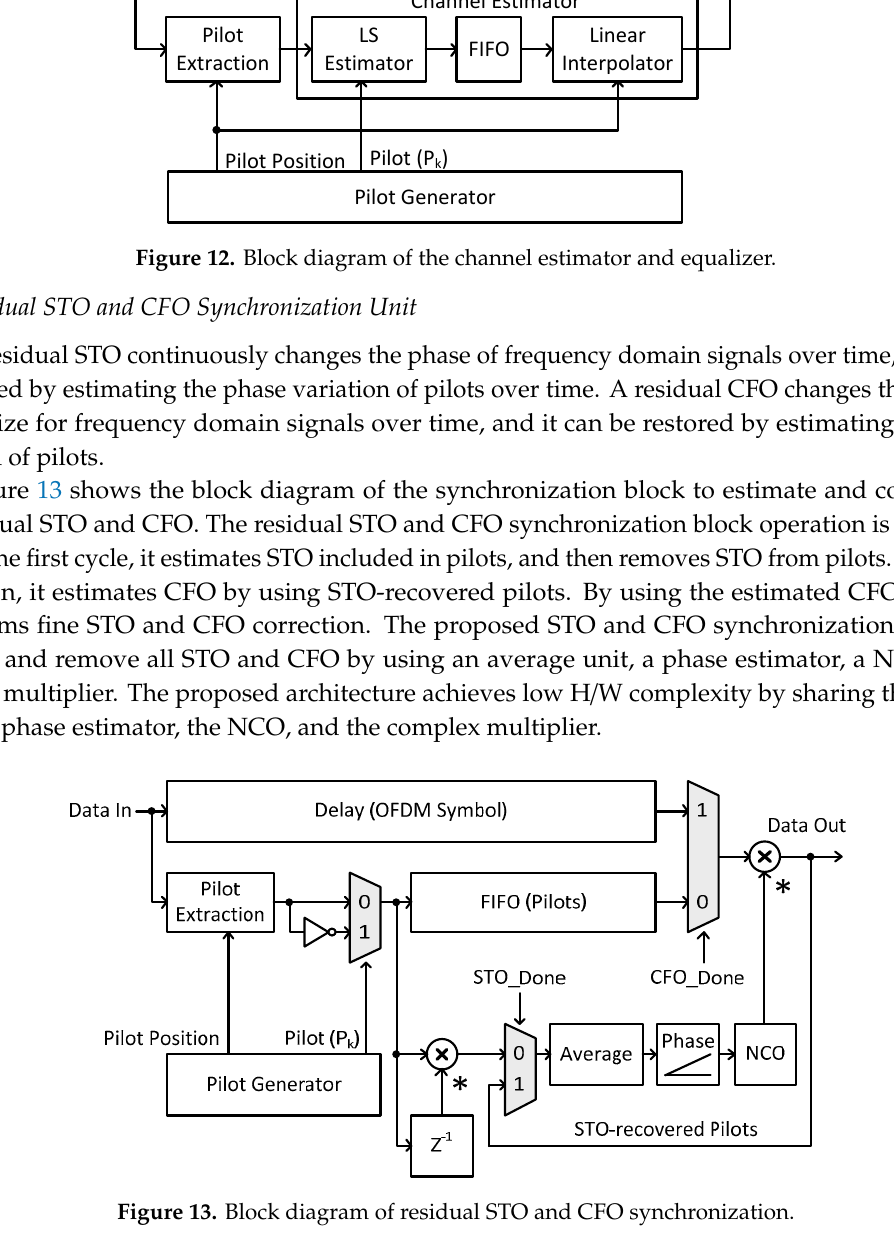
Figure 11. Block diagram of variable FFT. 4.4. Channel Equalizer Unit There are various scattered pilot patterns in DVB-T2 and DVB-C2 uses a part of the scattered